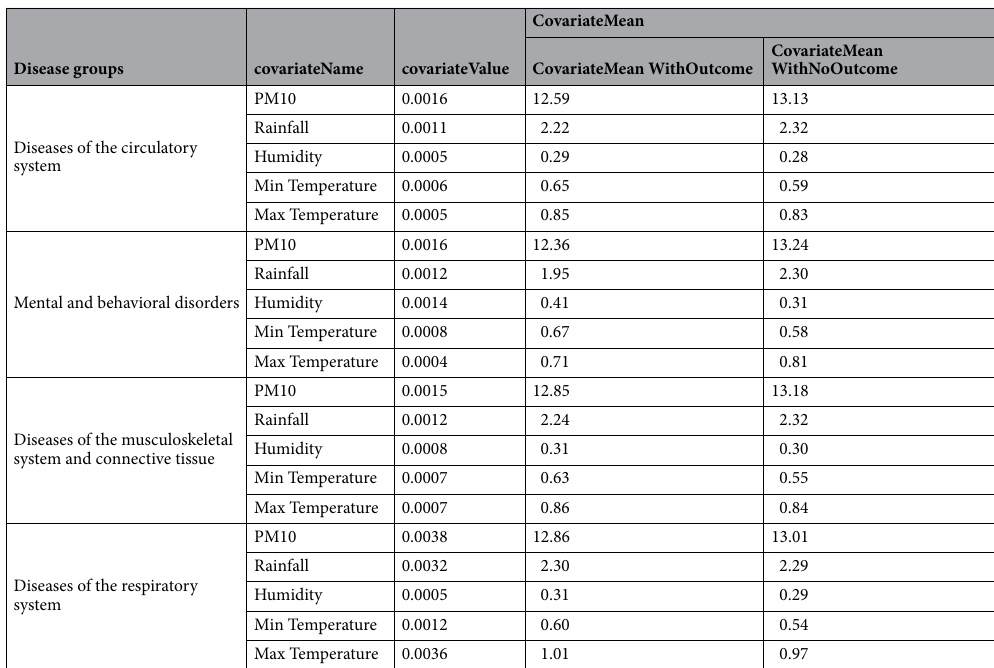
Table 4. Weather and air quality predictors in